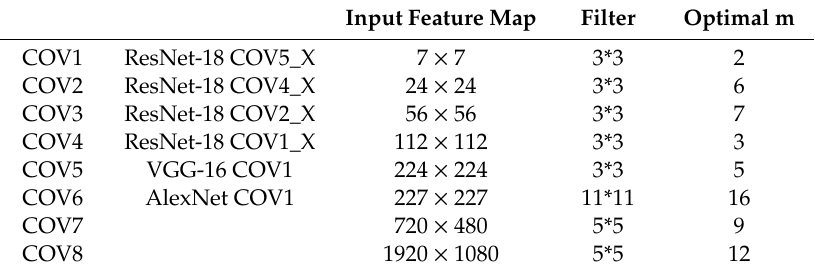
Table 1. Various types of convolutions and their optimal number of blocks.